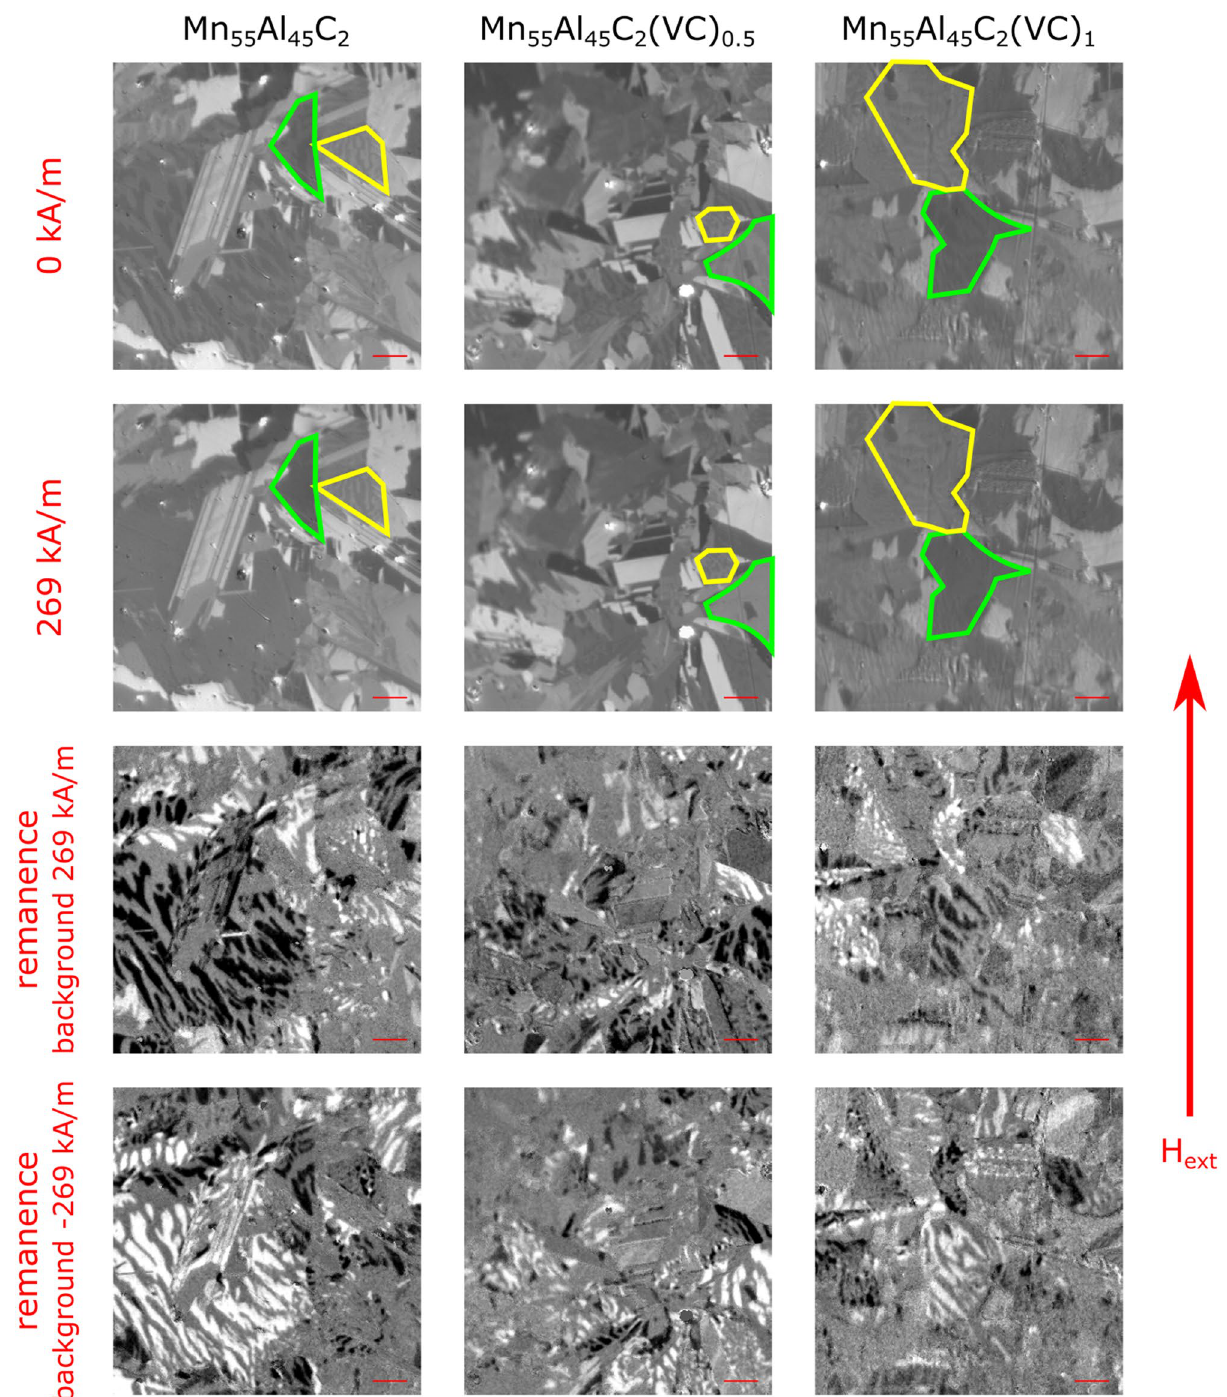
Figure 9. Kerr microscopy investigation of as-cast Mn 55 Al 45 C 2 , Mn 55 Al 45 C 2 (VC) 0.5 and Mn 55 Al 45 C 2 (VC) 1 alloys. The first row are measurements taken at 0 kA/m, while the second row shows images taken at an applied field of 269 kA/m. In all samples, grains can be identified which can be saturated (marked green) and which cannot be saturated (marked yellow). Row three and four illustrate the domain changes coming from 269 kA/m to 0 kA/m (third row) and coming from -269 kA/m to 0 kA/m (fourth row). As expected the domains in the grains are reversing their orientation (black to white and vice versa), but no obvious pinning sites can be identified. The images are cut-outs of the bigger measurements and represent 90 × 90 µm 2 , i.e. the same size as the MFM images in Fig. 8; the red scale bar illustrates 10